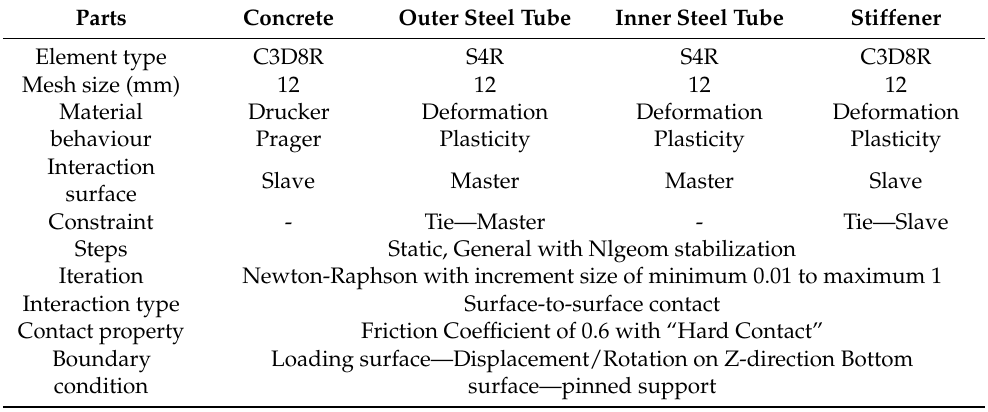
Table 7. Details of the finite element